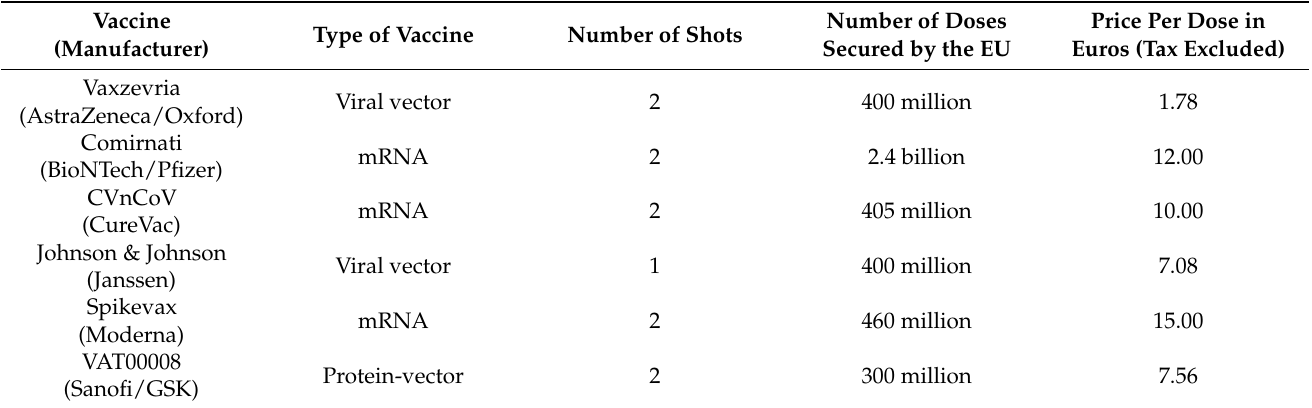
Table 2. Vaccines ordered by the European Union (EU): quantity and price